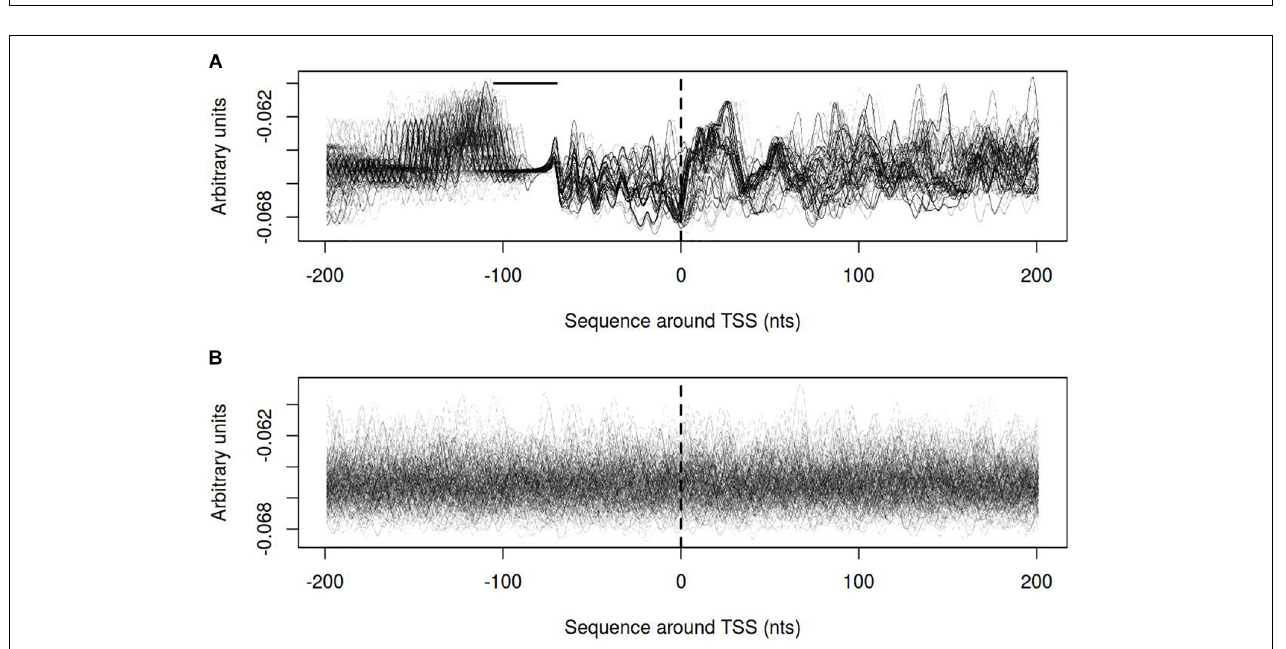
FIGURE 9 | Electrostatic potential (EP) profiles for (A) vlhA promoters of 12 M. gallisepticum strains; (B) sigma 70 promoters of S6 strain. Dashed line denotes transcription start site; solid horizontal line – approximate GAA repeats location.